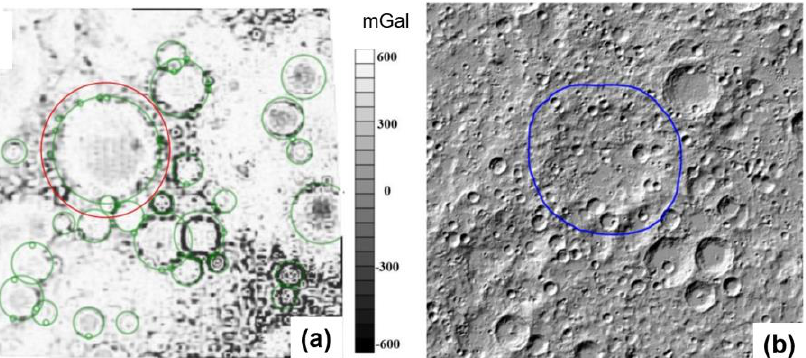
Figure 10. Comparison of the crater identification from gravity anomaly map and actual topography in Wugang Basin (( a ) the red circle represents the location of the abnormal contour of the basin circled manually by the researcher and the green circle denotes the crater identification by U-net, and ( b ) the blue circle denotes the location of the Wugang basin from DEM map).